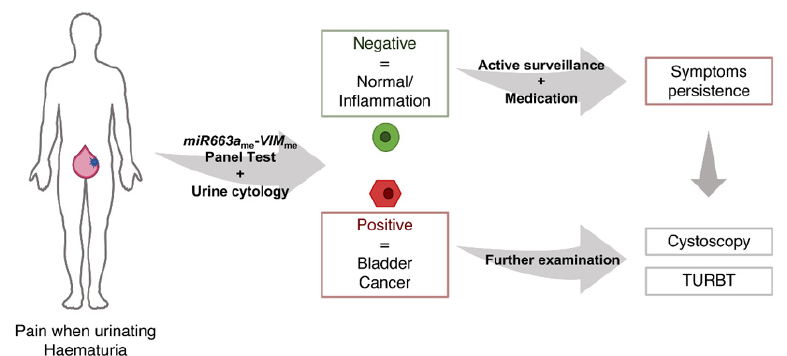
Figure 5. Proposed algorithm for the combination of urine cytology and VIM me - miR663a me panel as a first-line diagnostic tests in patients with common urinary complaints. (TURBT—Transurethral Resection of Bladder Tumour).